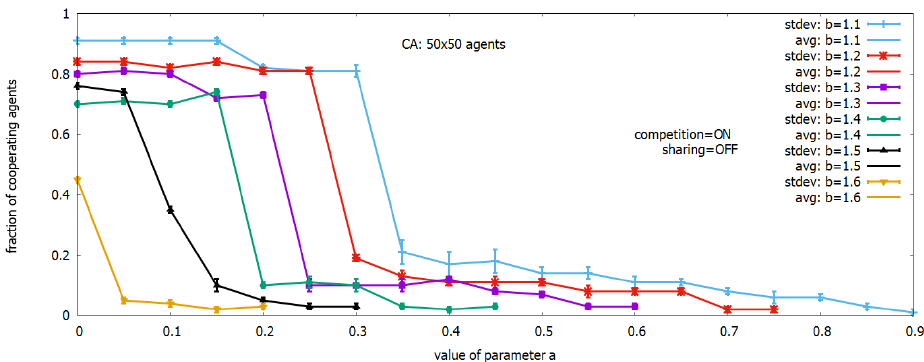
Figure 2. Level of cooperation of players in SPD games with 3 rules: all–C , all–D , and k–D as a function of parameters a and b .